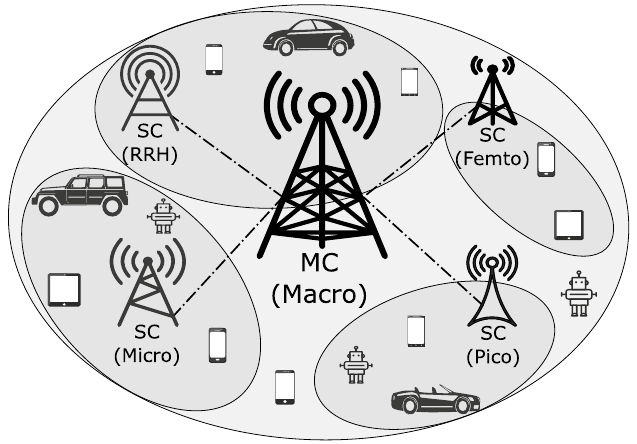
Figure 1. A CDSA HetNet unit consisting of a MC and densely deployed SCs within the coverage of the MC, SCs can be of type Remote Radio Head (RRH), Micro, Pico, and Femto BSs according to 25